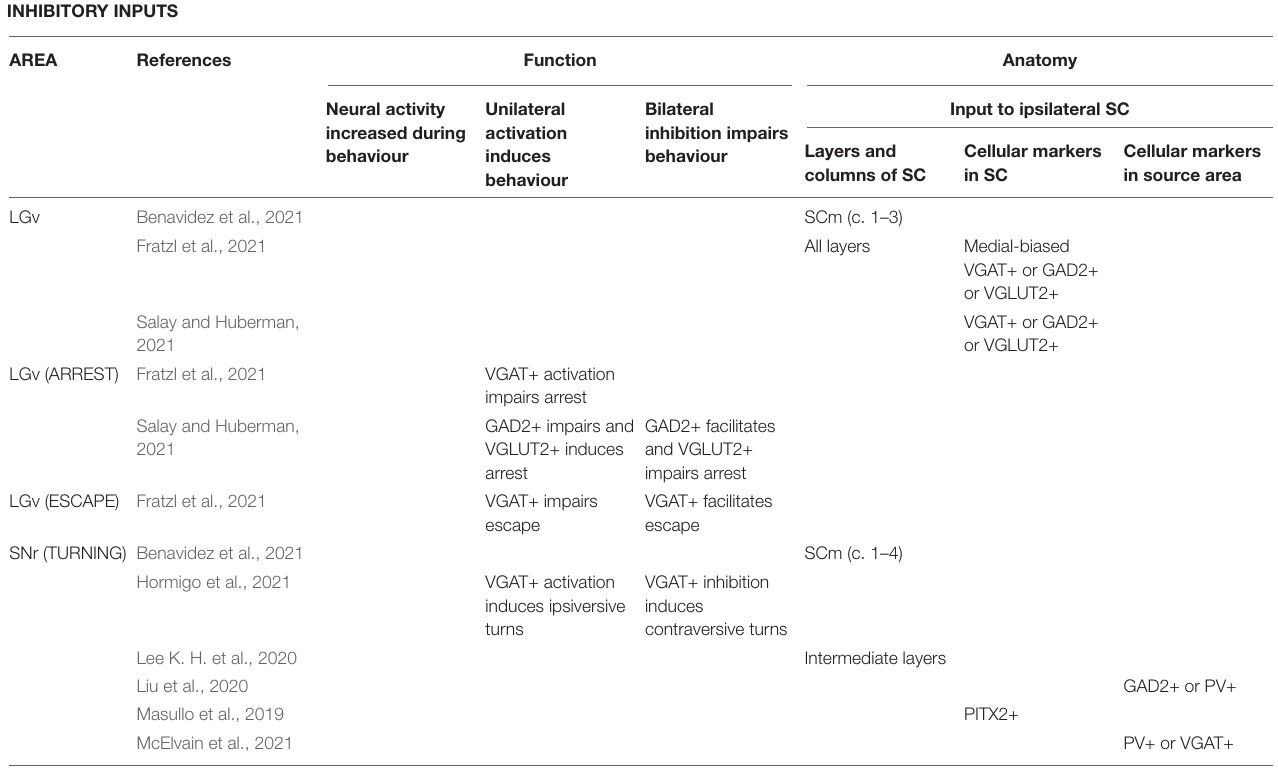
TABLE 5 | Areas providing inhibitory input to the